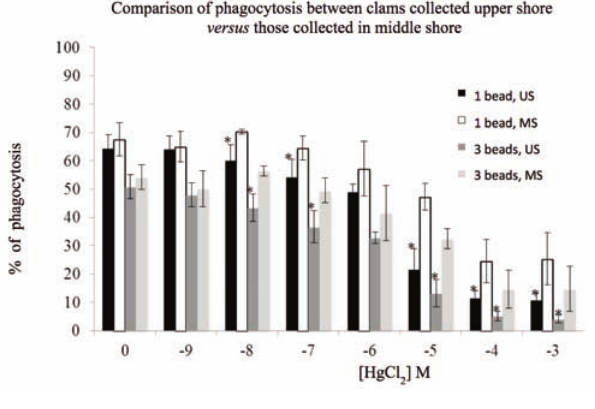
Figure 1. Phagocytosis activity (1 bead and more) and efficacy (three beads and more) of hemocytes obtained from Mya arenar- ia collected from middle (MS) and upper shore (US) at the Motel site in Metis Bay . Hemocytes were exposed to mercuric chloride at concentrations ranging from 0 up to 10–3 M. A significant suppression of phagocytic activity as well as efficacy was observed for hemocytes collected in the upper shore. *P ≤ 0.05. HgCl2, mer- curic